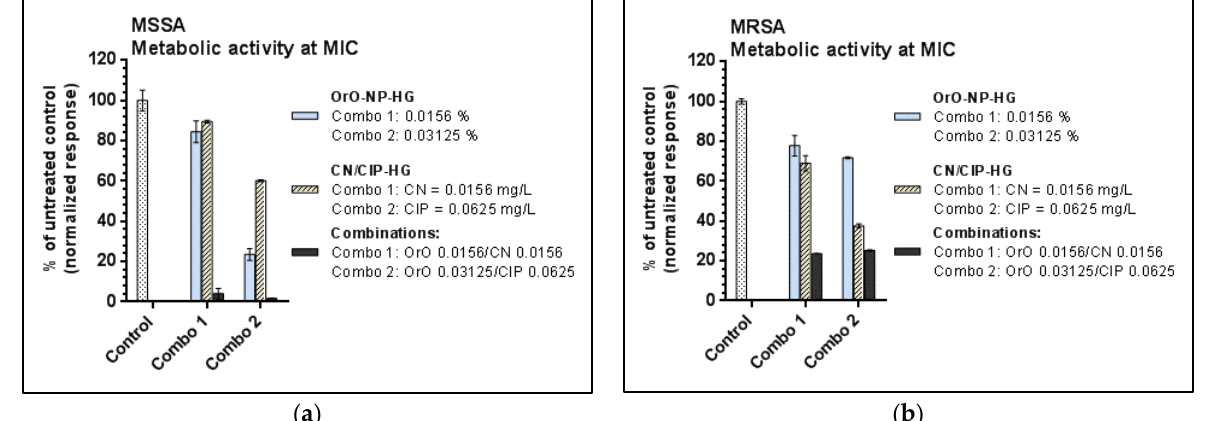
Figure 5. Metabolic activity of the test strains at the estimated minimal inhibitory concentrations — comparison between single treatment and combination effects: ( a ) metabolic activity of MSSA after exposure to OrO-NP-HG, CN-HG and CIP-HG or combinations; ( b ) metabolic activity of MRSA after exposure to OrO-NP-HG, CN-HG and CIP-HG or combinations. Legend: CN — gentamicin; CIP — ciprofloxacin; OrO-NP-HG — nanoparticles with oregano oil included in hydrogel.